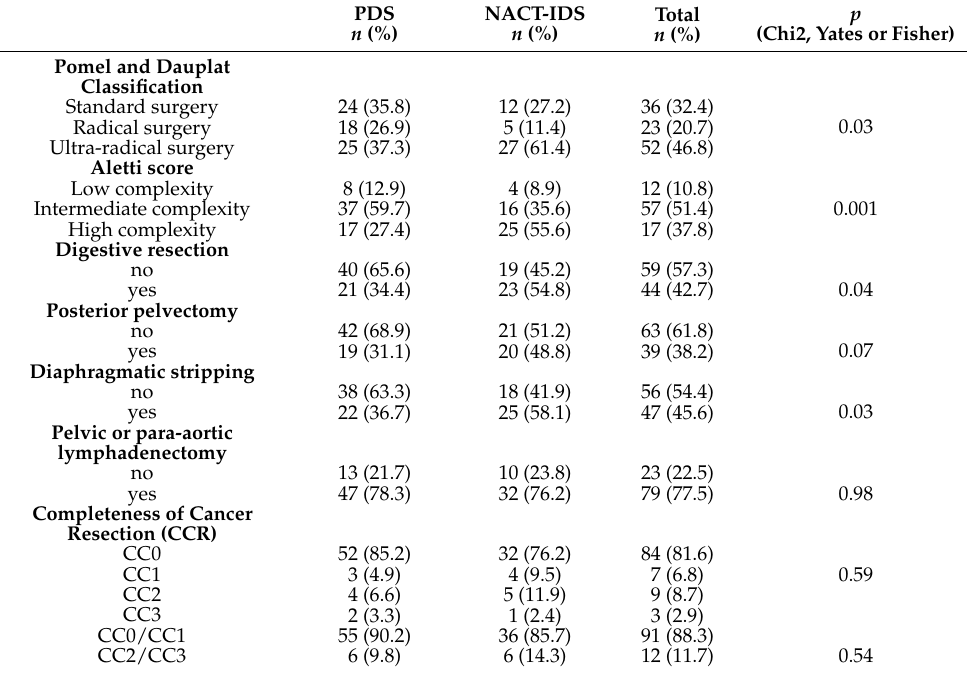
Table 2. Comparison of the PDS and NACT-IDS populations (surgical characteristics).